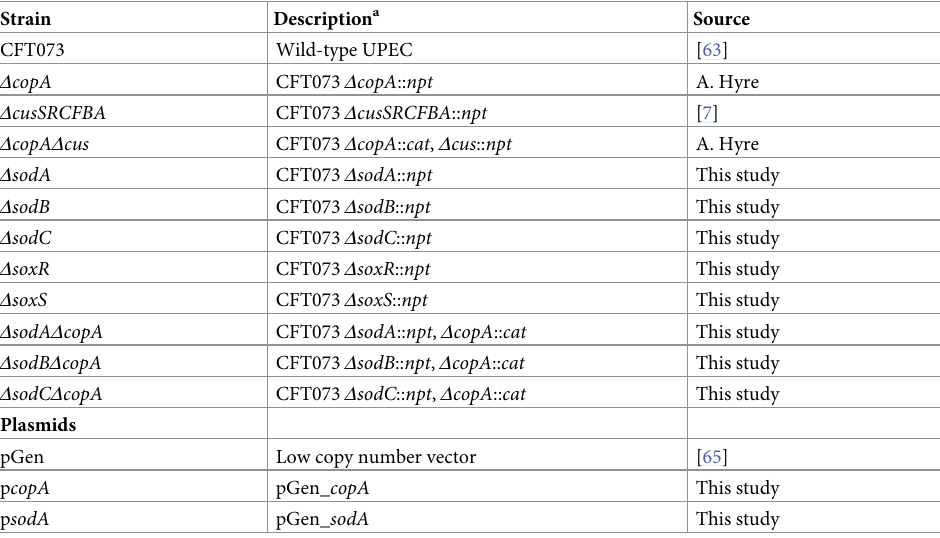
Table 1. Strains and plasmids used in this study.